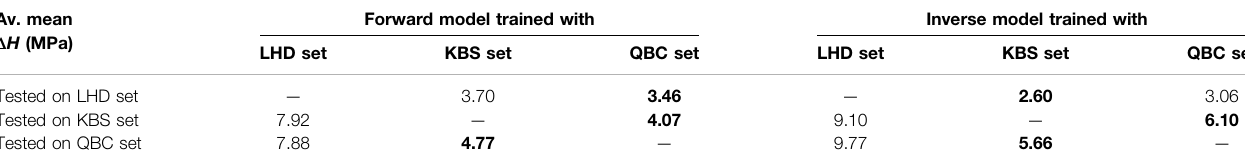
TABLE 1 | Averaged mean Δ H for the neural networks that are trained and evaluated using the three data sets. The data sets are generated using LHD (Latin hypercube design), KBS (the knowledge-based sampling approach), and QBC (query-by-committee). The best result for each test set is marked in bold. Av. mean Forward model trained with Inverse model trained with Δ H (MPa)